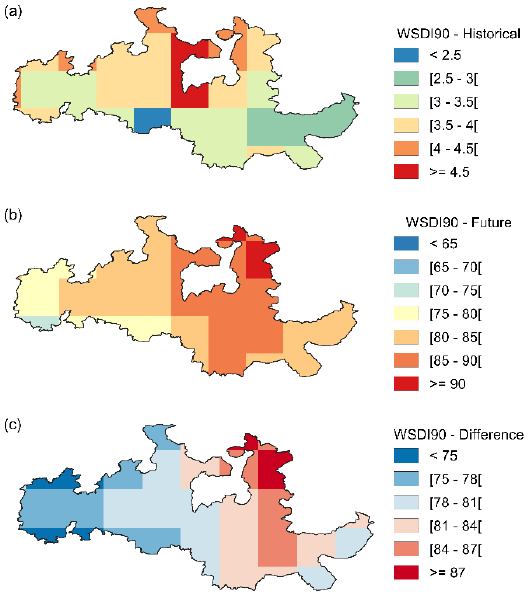
Figure 10. Ensemble-mean of the Warm Spell Day Index above the 90th percentile (WSDI90) for the Douro Wine Region, bias-corrected by quantile mapping, for the ( a ) historical (1989–2005), ( b ) future (2051–2080) under the RCP8.5, and ( c ) future historical difference. For the future period, an increase in the CDD index is also expected (Figure 11), which will be particularly apparent in the westernmost part of the DWR (>65 days), which is currently less exposed to droughts. The eastern region is already today quite dry, which explains the lower increases in CDD. On the other hand, for the NDS index (Figure 12), its values almost double throughout the DWR, mainly in the more continental (inner) region,